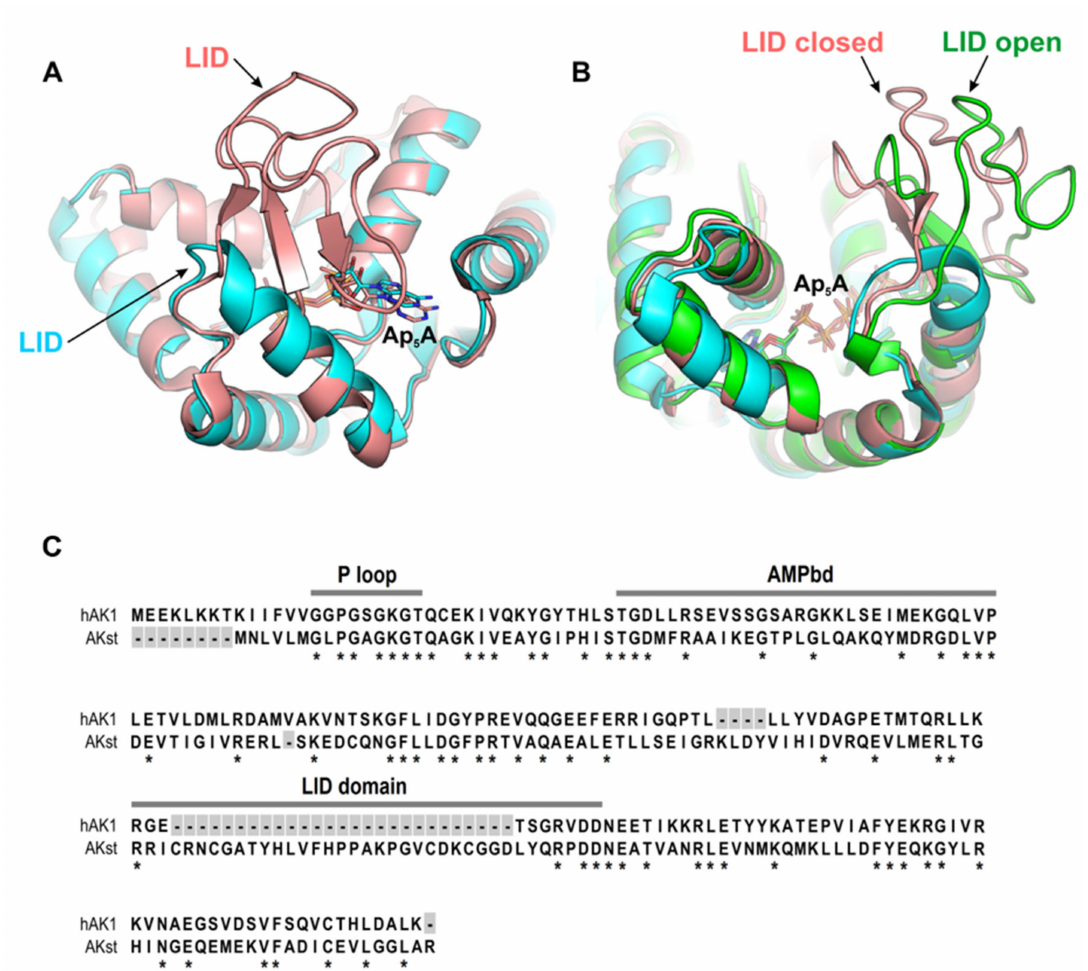
Figure 7. ( A ) Superposition of hAK1 (cyan) (PDB ID: 1Z83) and AKst (light pink) (PDB ID: 4QBH) showing the main structural difference between these two AKs. ( B ) The LID domain in AKst in a closed (light red, PDB ID: 4QBH) and open (green, PDB ID: 1ZIN) state. ( C ) Comparison of amino acid sequences of AKs with marked functional domains AMPbd and LID and the NTP-binding site (P loop). Asterisk indicates a conserved amino acid residue at each alignment